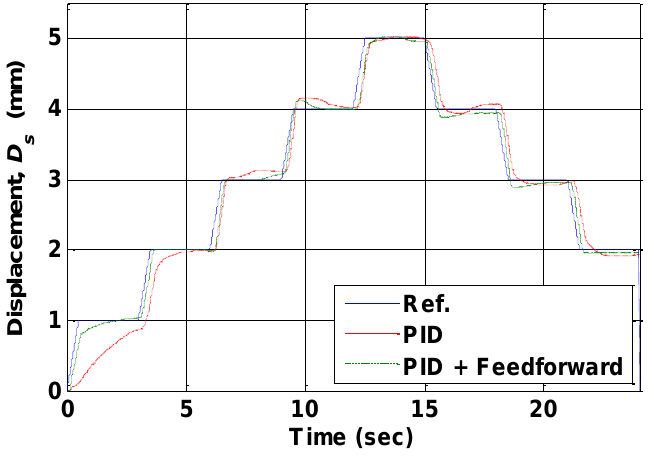
Figure 14. Experimental results for a multi-step reference